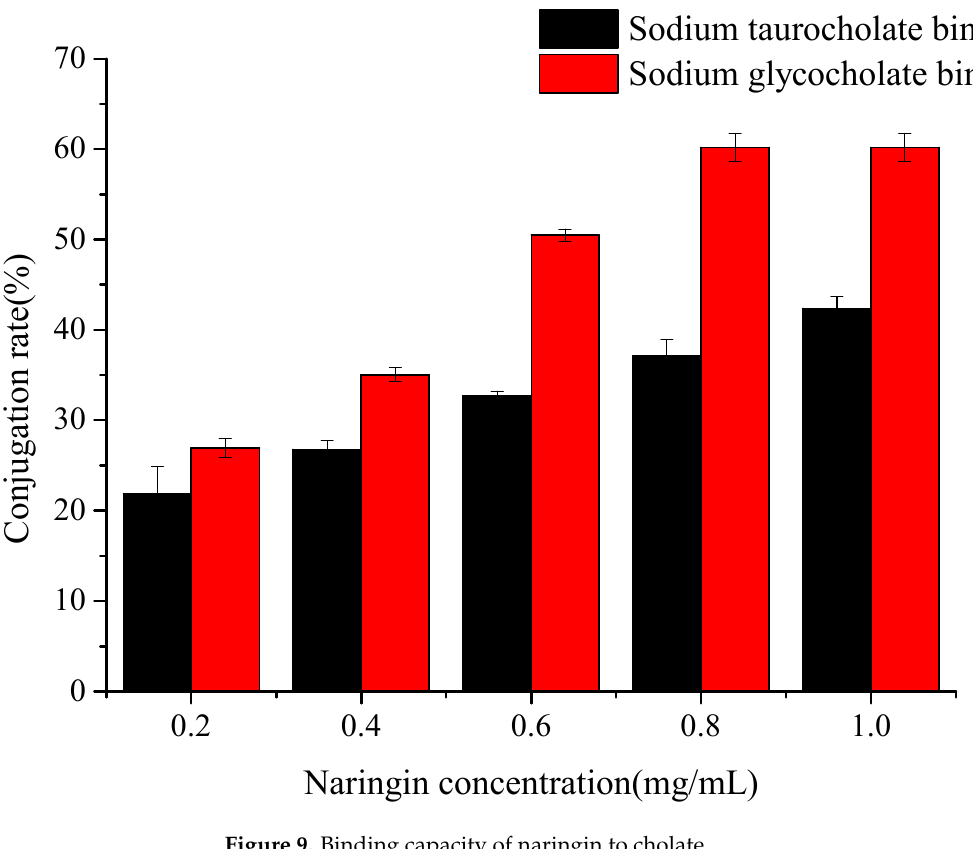
Figure 9. Binding capacity of naringin to cholate.